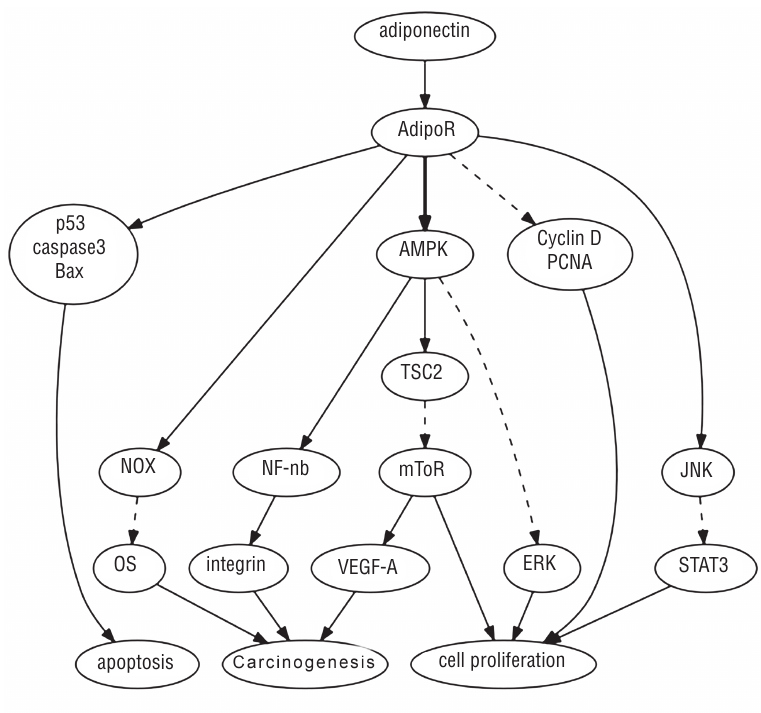
Figure-1 - Signaling pathways of adiponectin in prostate cancer